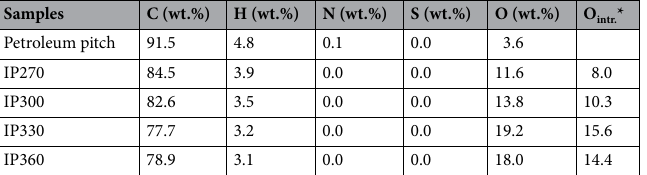
Table 1. Elemental analysis of surface oxidized pitch at various surface oxidation temperatures. *Amount of oxygen uptake.